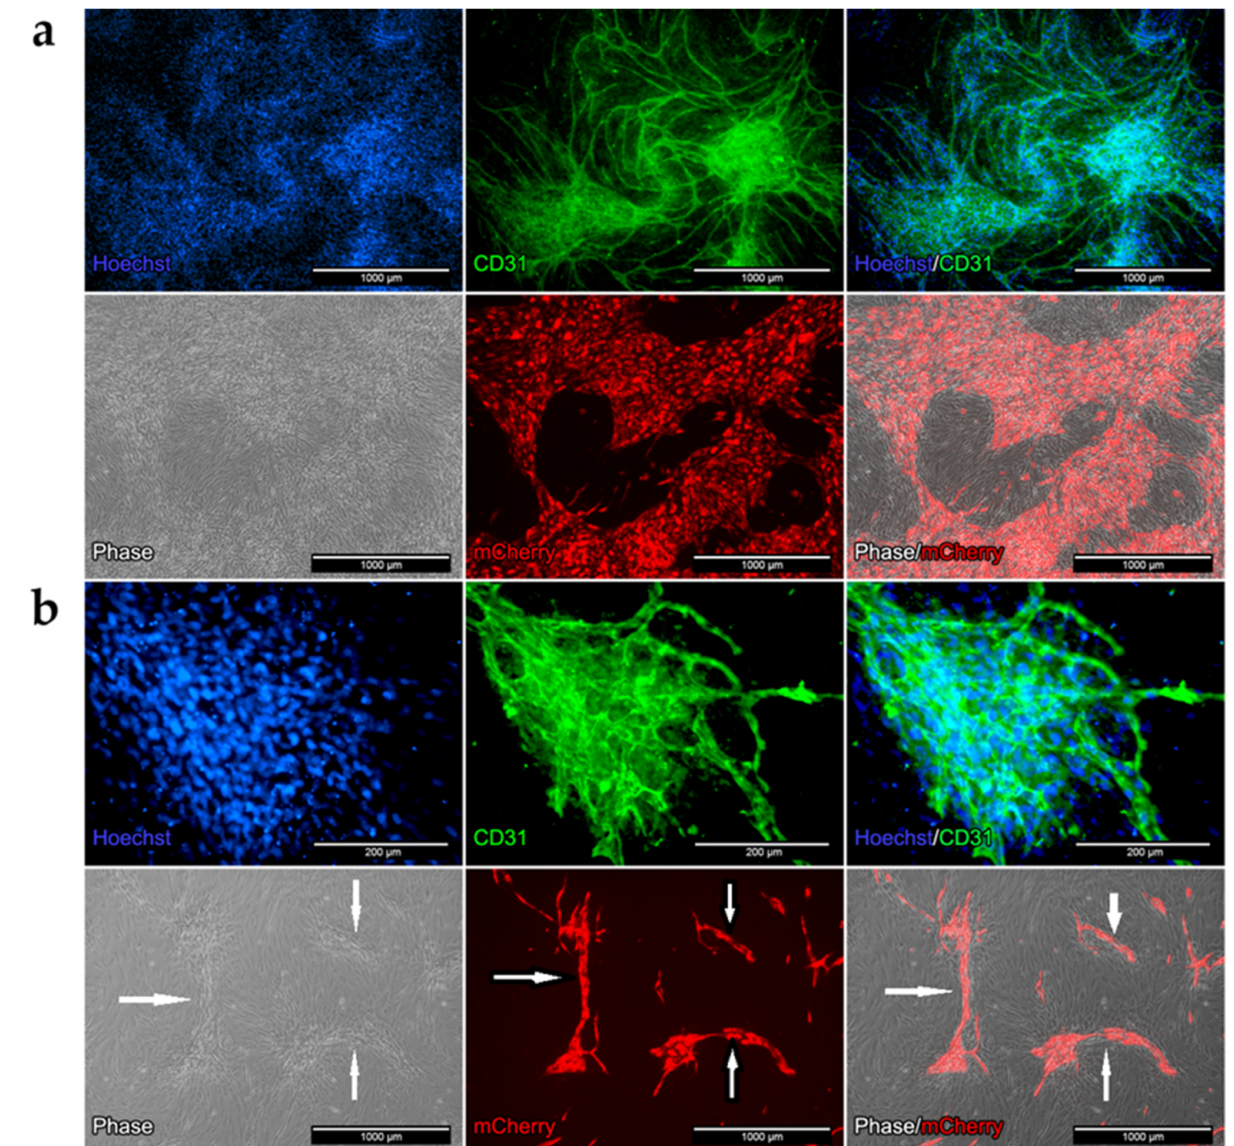
Figure 6. Immunofluorescence of the co-culture after 5 days in HM1/DM ( a ) and in DM ( b ) medium. Cells were stained with CD31 specific antibody (green). Nucleus staining was performed with Hoechst dye (blue). Phase contrast images of the co-culture (( a , b ), grey). HUVECs transduced with the mCherry vector (( a , b ), red) in the co-culture; overlay of the phase contrast images and the transduced HUVECs (red, grey). Myoblasts were not